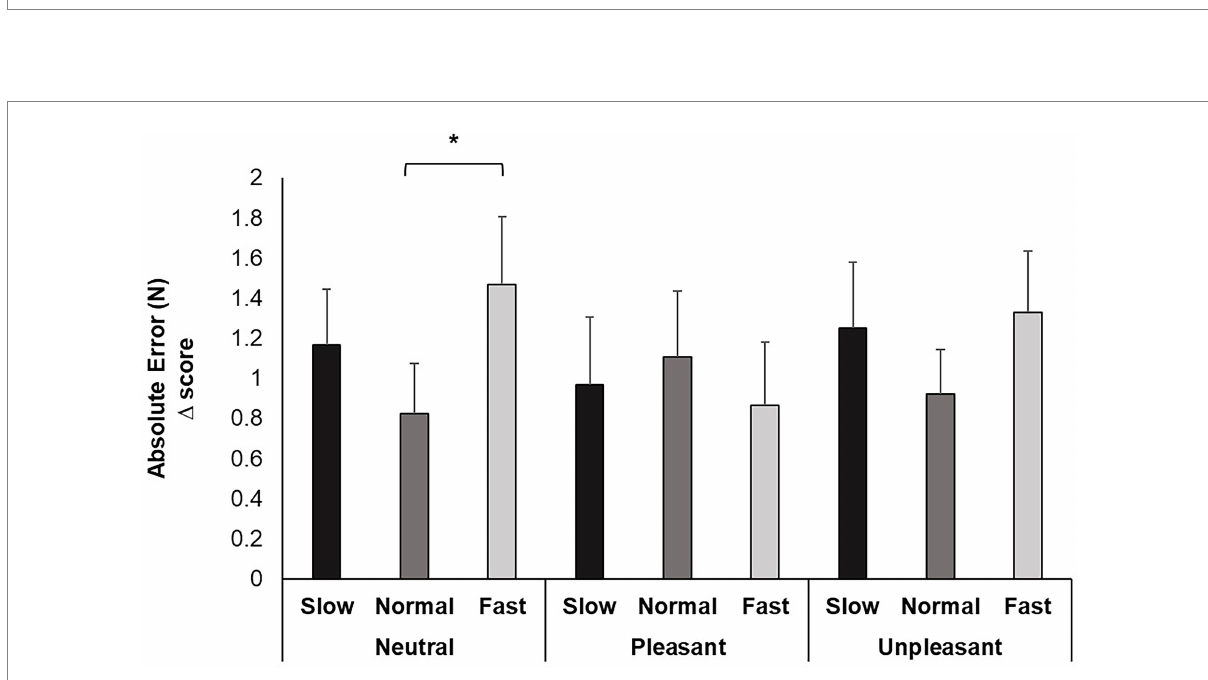
FIGURE 3 Mean AE change scores for each breathing frequency condition and image valence in milliseconds (ms). Greater values indicate less accuracy attaining target force. Error bars represent +1 SE from the mean. Asterisks represent significant differences ( p <